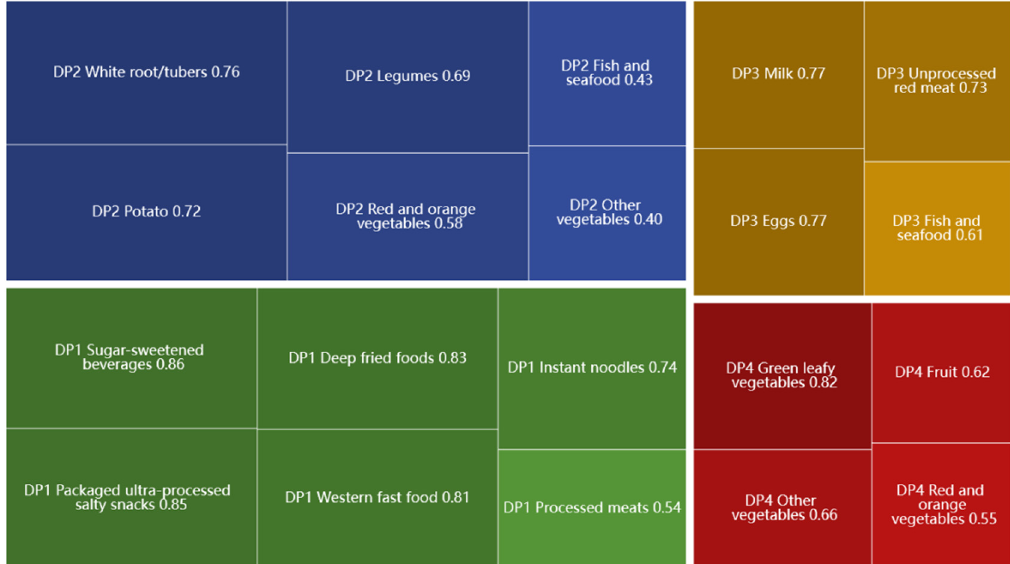
Figure 3. Factor loadings of various food items in each dietary pattern.